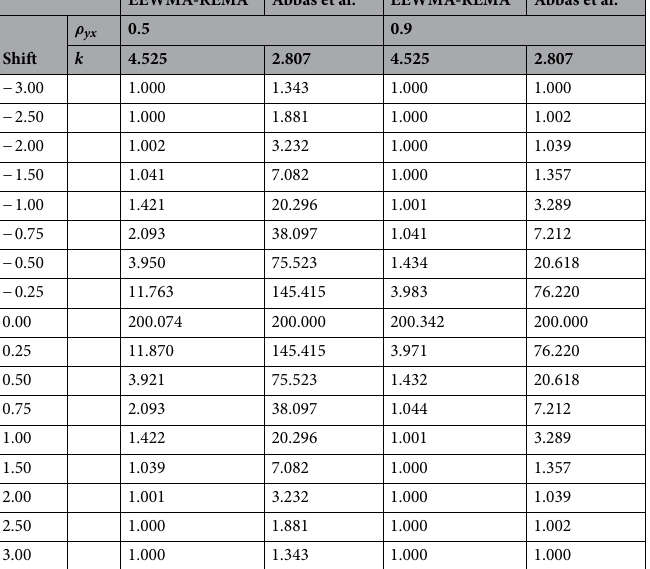
Table 12. Comparisons of the proposed EEWMA-REMA control chart ( n = 5, w = 5 ) versus Ref. 47 when = 200 ARL 0